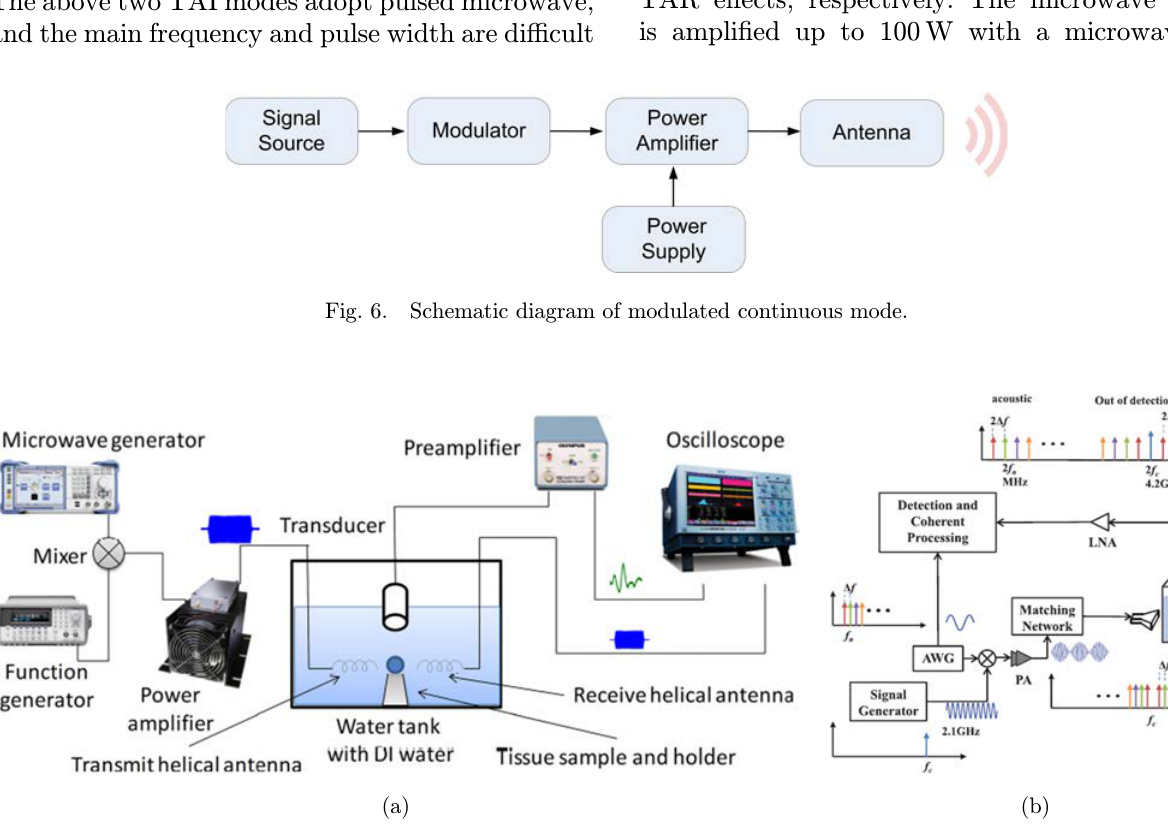
Fig. 7. (a) Schematic diagram of the experimental setup for the observation of both TA and TAR e®ect induced by single-pulse and multi-pulse microwave source. (b) The schematic of the experiment setup. The AWG sends out the stepped-frequency envelope signal that modulates the microwave carrier.